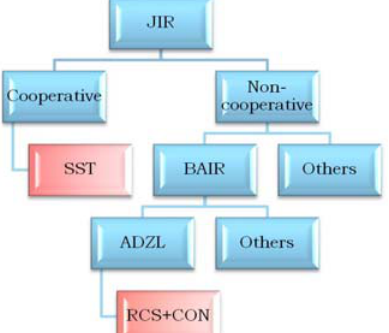
Fig. 4. Investigated communication complex - BAIR-detector. SST ... spread- spectrum technology, RCS ... reliable chip selector, CON ... threshold control module, ADZL ... Adaptive Dead Zone Limiter, B ch ... channel